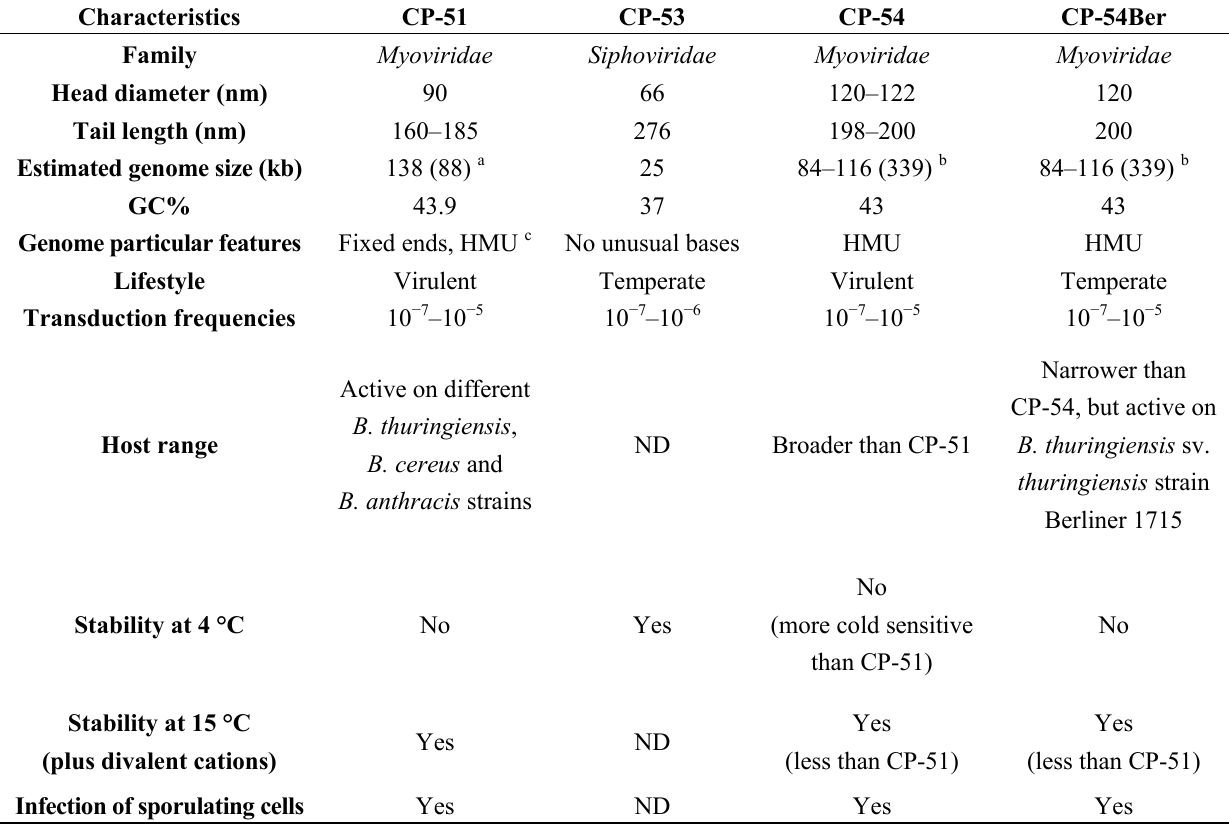
Table 5. Main characteristics of phages CP-51, CP-53, CP-54 and CP-54Ber.